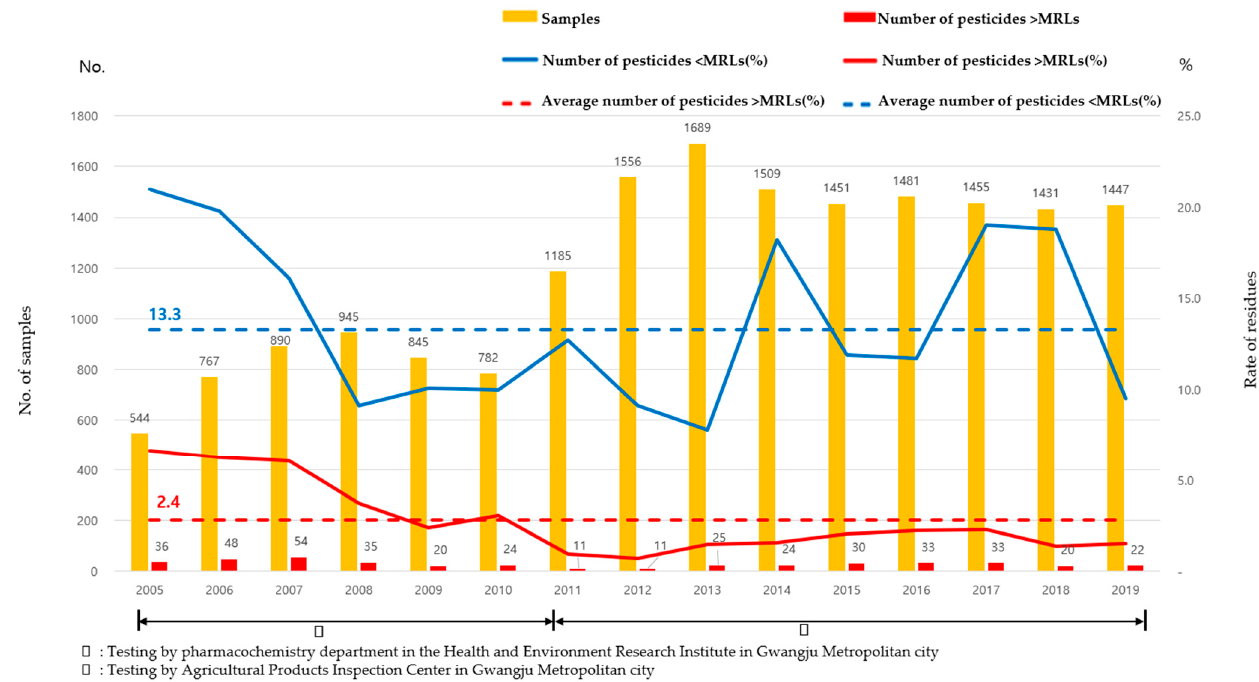
Figure 1. Samples analyzed by the monitoring programs of pesticide residues (Gwangju Metropolitan City) from 2005 to 2019: Trends in the annual number and percent (pesticides residues < MRLs and > MRLs).